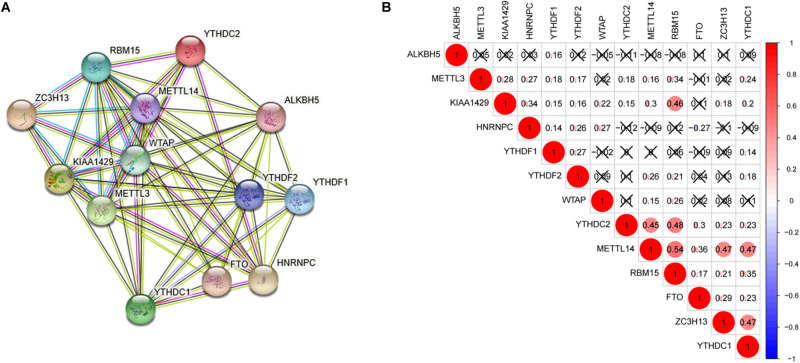
Interaction and correlation among the 13 m6A RNA methylation regulators. (A) The PPI network was constructed to show the interaction among m6A RNA methylation regulators. (B) The Pearson correlation analysis was used to evaluate the correlation among m6A RNA methylation regulators.